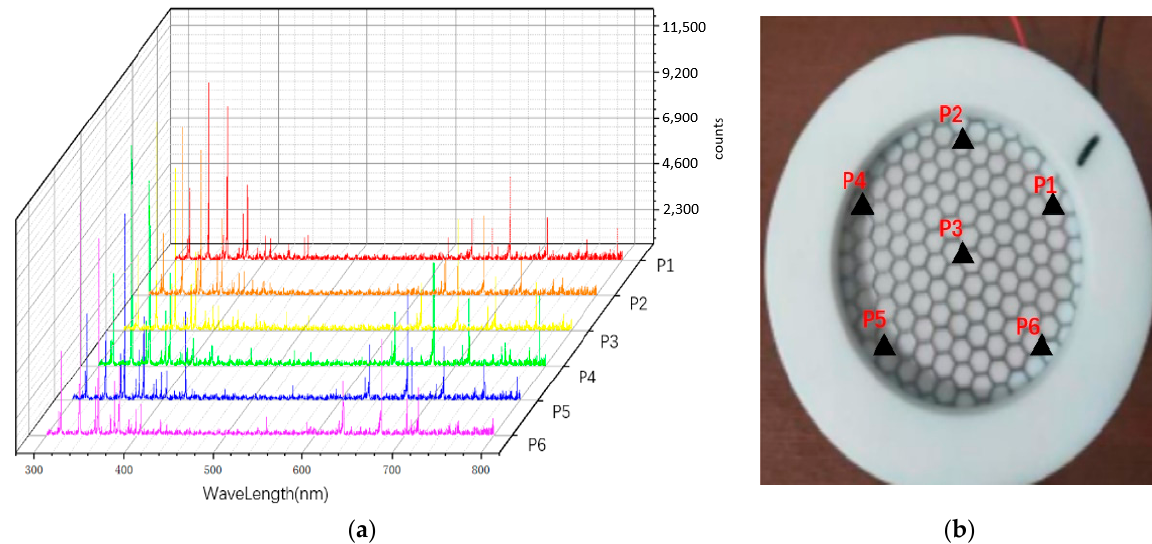
Figure 3. Portable detection of surface discharge uniformity: ( a ) emission spectra of six randomly selected points; ( b ) distribution of the six points.